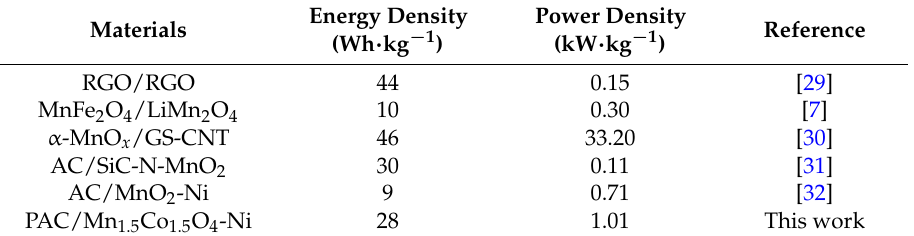
Table 3. Comparison of carbon-based and metal oxide electrodes used for